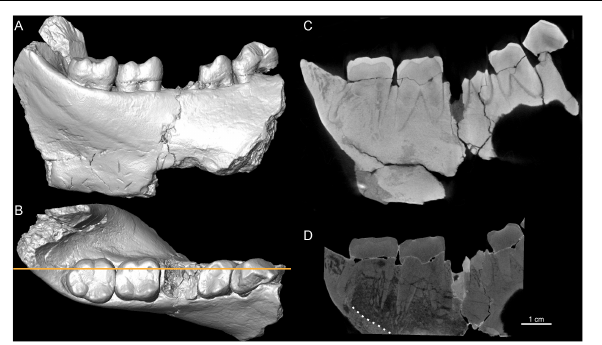
FIGURE 2 | 3D virtual rendering of the Sivapithecus parvada left mandibular corpus, SNSB-BSPG 1939 X 4, in lingual (A) and occlusal (B) views. The longitudinal virtual sections through the corpus [orange line, in (B) ] were extracted from the X- µ CT (C) and n- µ CT (D) records, respectively. The dotted white line in (D) shows the endosteal margin of the cortical bone, not visible in (C)